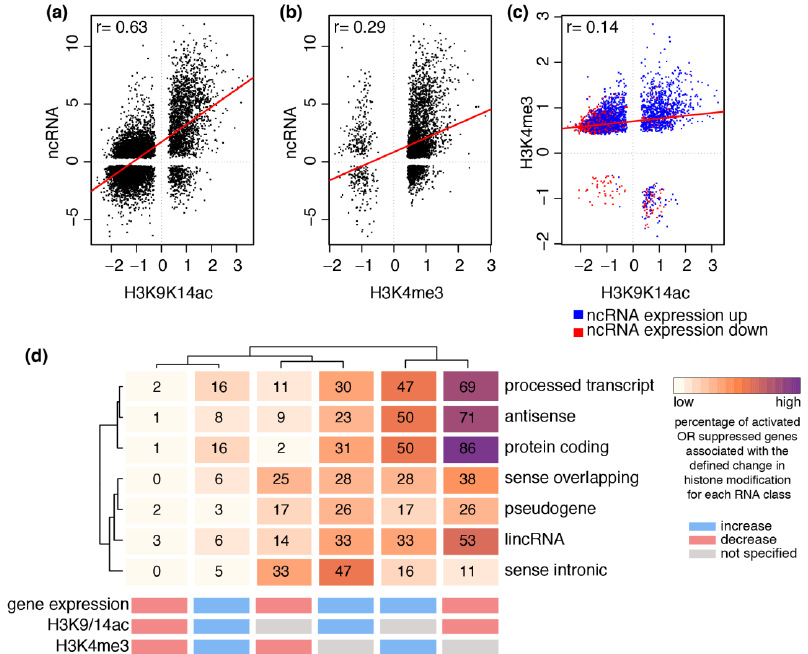
Figure 3. Epigenetic regulation by SAHA is dependent on ncRNA type. Scatterplots plots of the fold changes (logFC) show the correlation between ncRNA expression (FDR p value < 0.05) and corresponding promoter ( a ) H3K9/14ac and ( b ) H3K4me3 (FDR p value < 0.05) in response to SAHA stimulation; ( c ) A scatterplot of the fold changes (logFC) shows the correlation between differential promoter H3K9/14ac and H3K4me3 (FDR p value < 0.05) for ncRNA genes that are either activated (blue) or suppressed (red) (FDR p value < 0.05). Linear model is shown in red and the Pearson’s correlation value is reported for each plot; ( d ) A heatmap showing the percentage of activated or suppressed genes that overlap with increased or decreased histone modification (defined on horizontal axis) for protein-coding genes and six ncRNA classes (vertical axis).